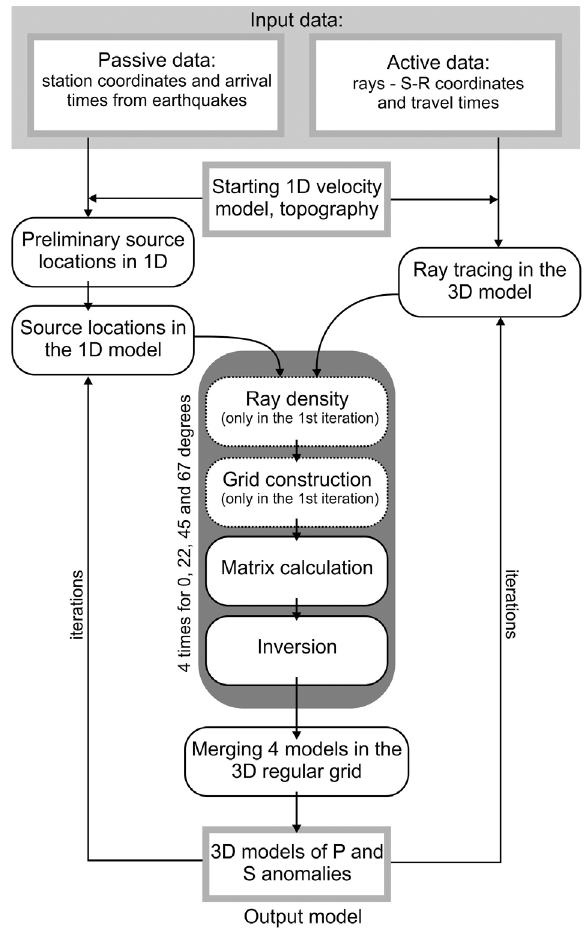
Figure 1. Schematic PARTOS workflow for active and passive data. Rectangles represent the data files and rounded blocks depicts the steps of the program. Steps with dotted lines are performed only once in the first